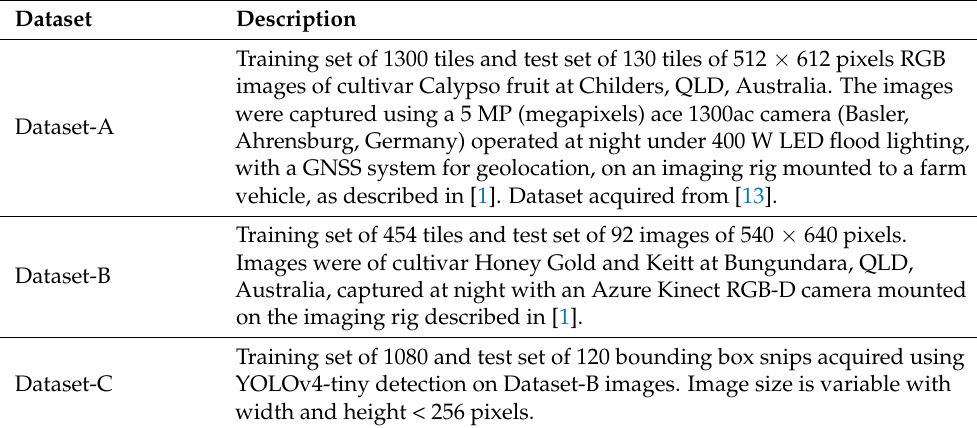
Table 1. Description of image datasets used for training and testing object detection and instance segmentation